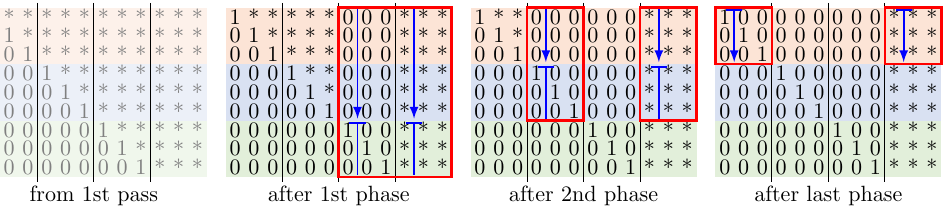
Figure 3: Visualization of the data memory for the dual-pass approach for an ( n − k ) × n = 9 × 12 matrix using a column-block size of s = 3. Asterisks denote random data. Corresponding sets of rows are marked in the same color. Red boxes show which matrix parts have been